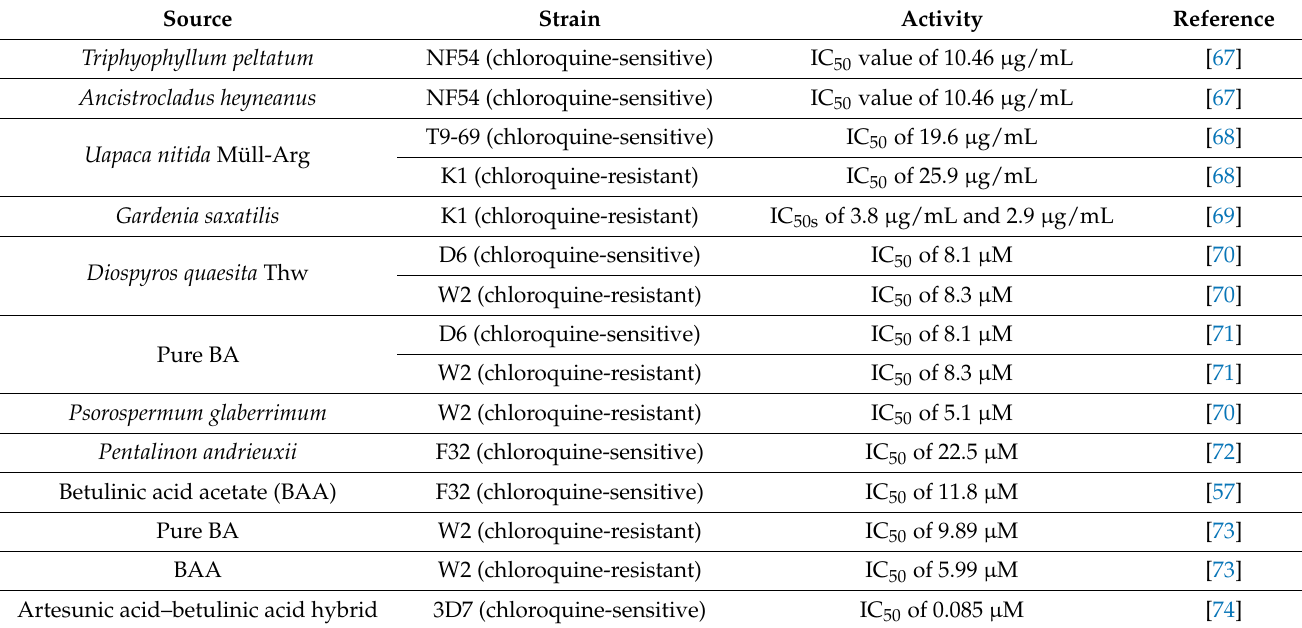
Table 3. Summarized activity of betulinic acid against Plasmodium